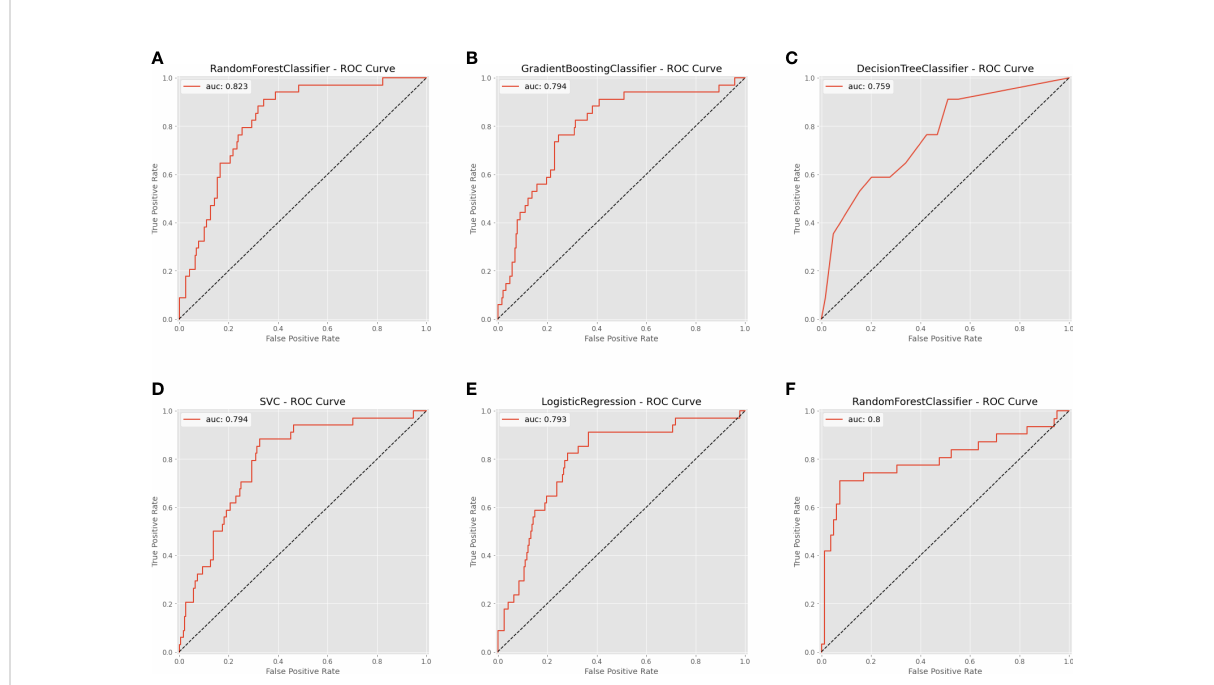
FIGURE 3 Area under the receiver operating characteristic curve (AUROC) for the machine learning-based models. (A) Random Forest for internal validation; (B) Gradient Boosting Machine; (C) Decision Tree; (D) Support Vector Machine; (E) Logistic Regression; (F) Random Forest for external